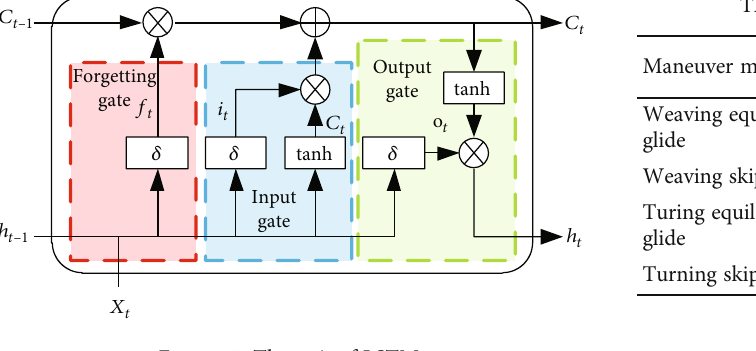
Figure 5: The unit of LSTM.